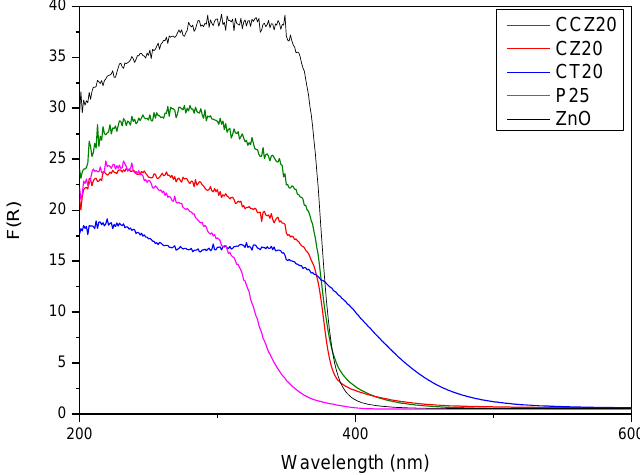
Figure 11. Kubelka – Munk function obtained by DRS analysis of Ce-doped samples.